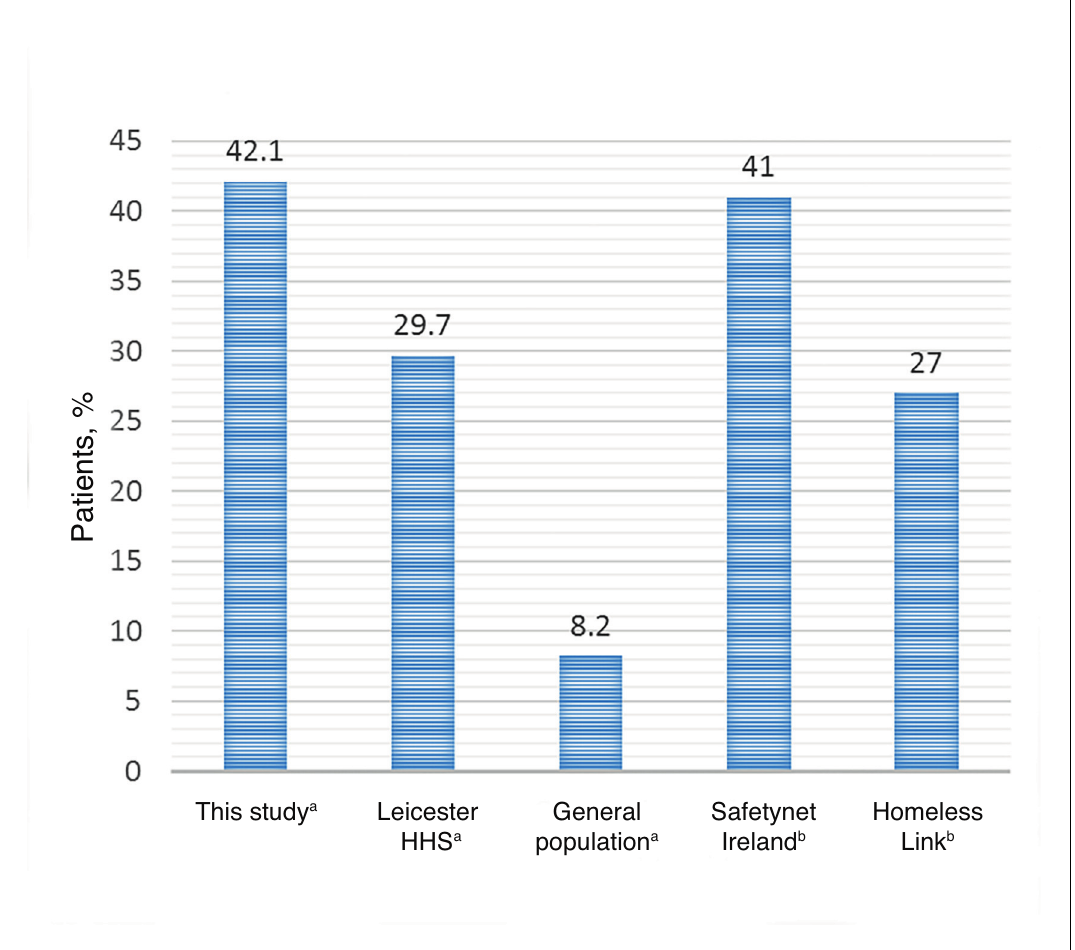
Figure 2. Prevalence of depression in this study versus other homeless cohorts 3,5,7 and a population-representative sample from general practice records. 8 a Clinically recorded data. b Self-reported data. HHS = Homeless Healthcare